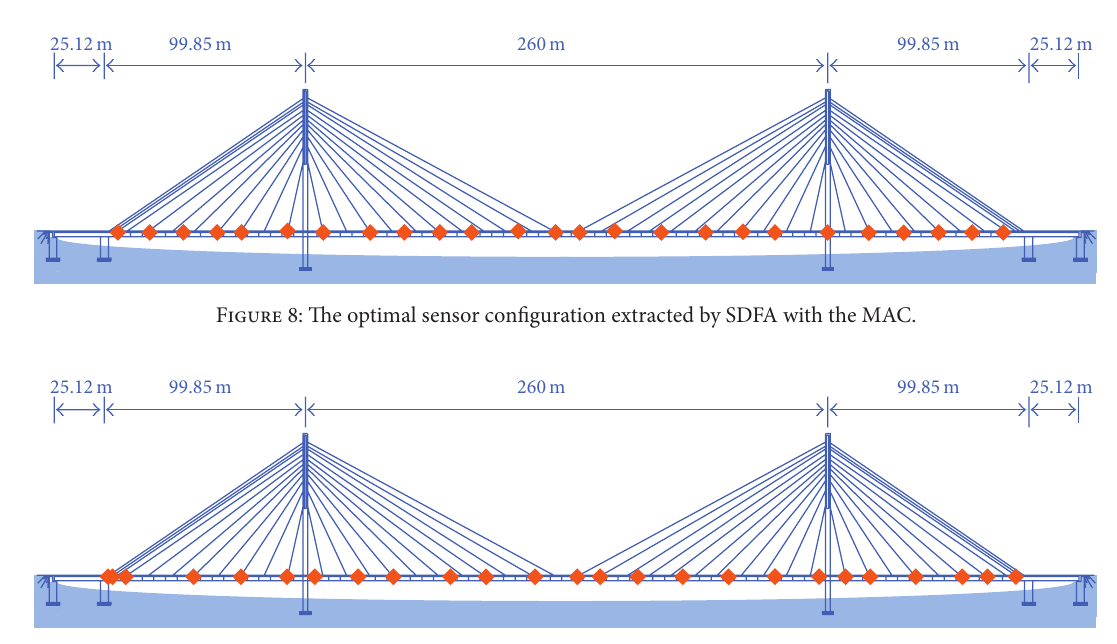
Figure 9: The optimal sensor configuration extracted by GA with the